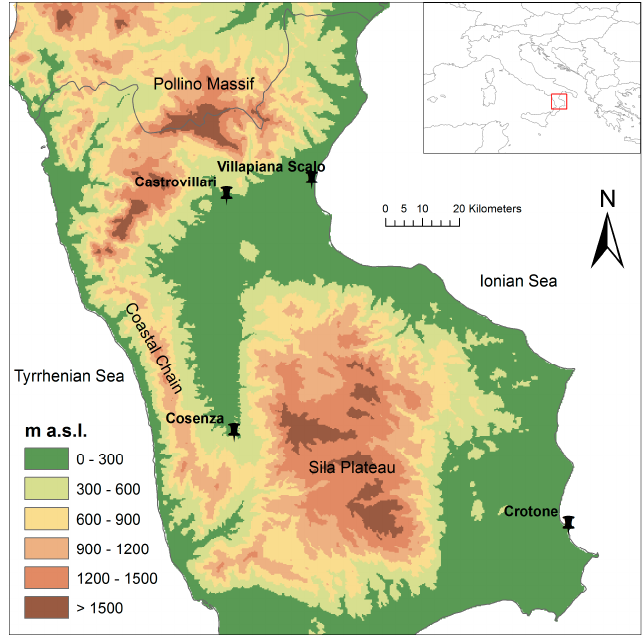
Figure 1. Location of the selected gauges in the Calabria region. Table 1. Percentages of missing values of monthly mean temperature and cumulated rainfall.